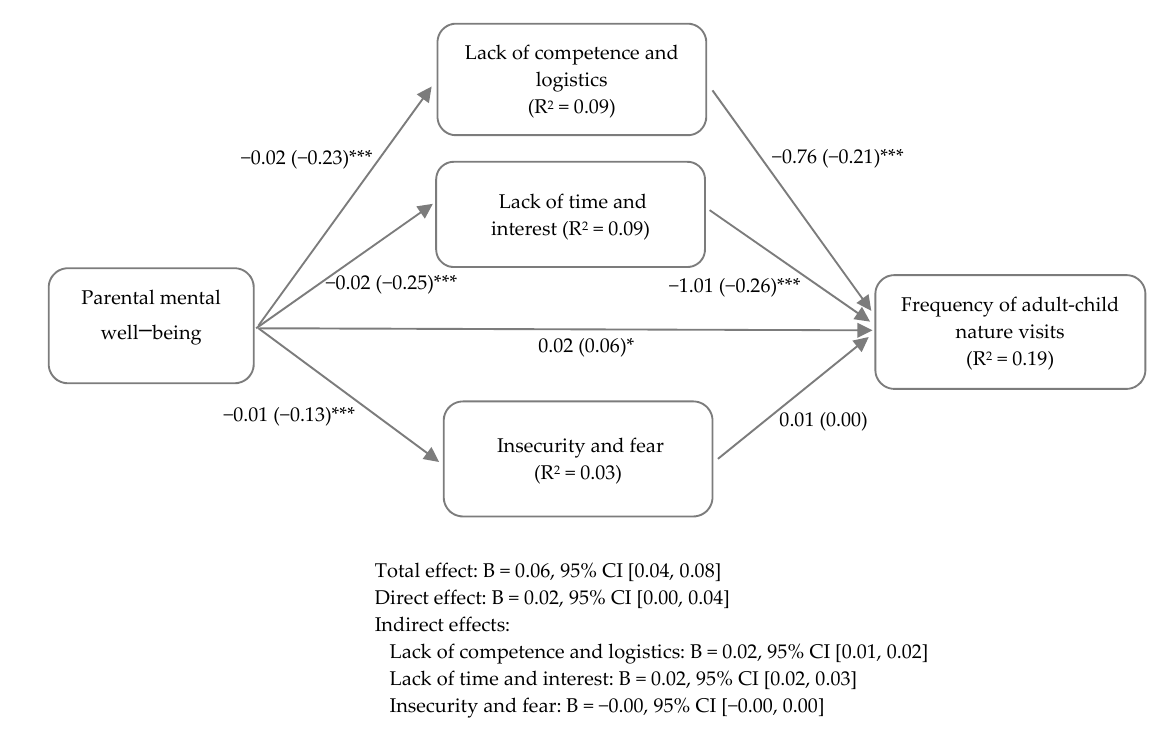
Figure 3. Parents’ perceived barriers as mediating variables in relationship between parental mental well-being and frequency of adult-child nature visits. Unstandardized regression coefficients (B) with standardized regression coefficients ( β ) in parentheses. All mediating variables included in the same model. Adjusted for background variables of child age, household type, parental educational attainment, and parents’ perceived economic situation. *** p < 0.001; * p < 0.05.